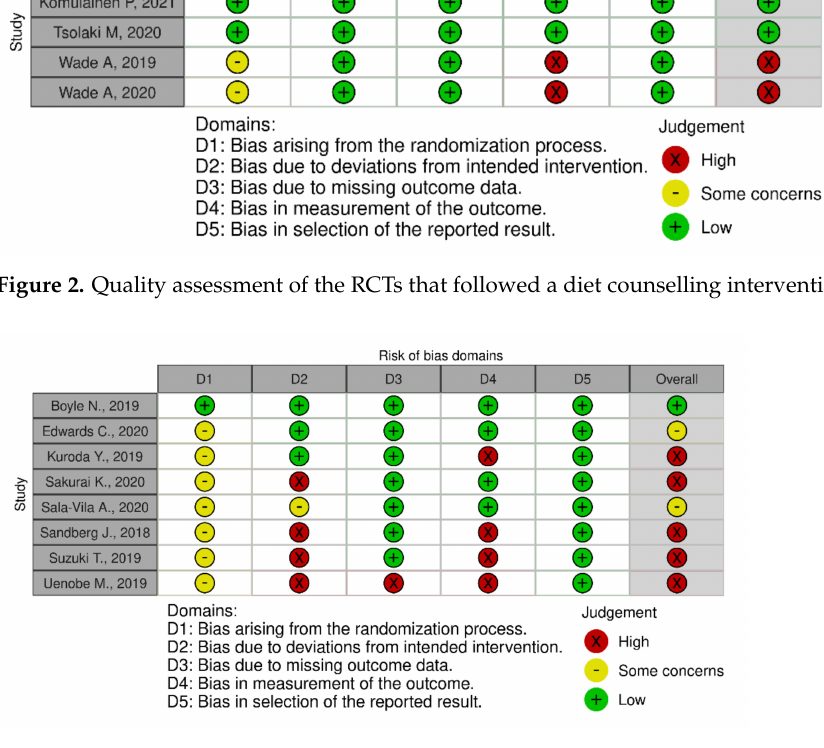
Figure 3. Quality assessment of the RCTs that followed a food-based